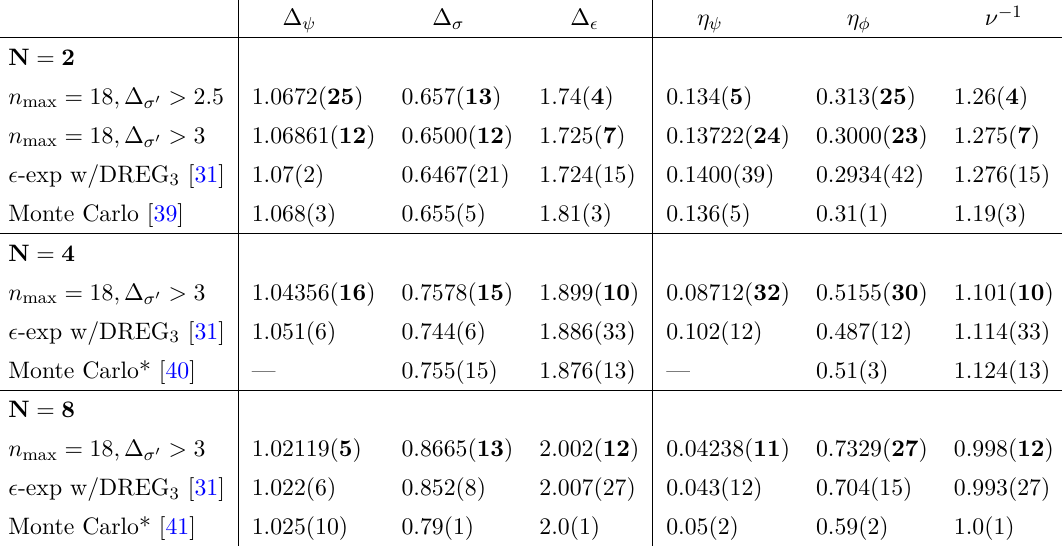
Table 1 . A summary of the bootstrap estimates obtained in this paper for the three external operator that we study. Error bars in bold are rigorous. 1 We compare these result to those obtained from the (cid:15) -expansion and previous Monte Carlo studies. Methods denoted by * indicate that they study the closely related chiral Ising fixed point as opposed to the model studied in this work. The (cid:15) -expansion work [31] relies on the DREG prescription to analytically continue spinors away from d = 4 3